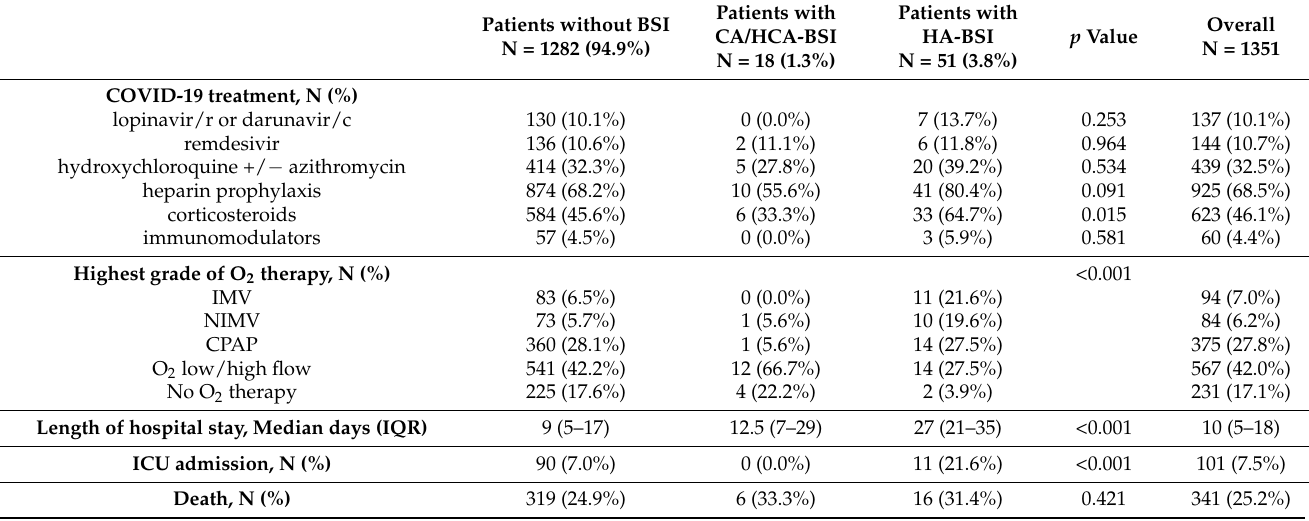
Table 2. Treatment and clinical outcomes of 1351 patients hospitalised with COVID-19. Patients without BSI N = 1282